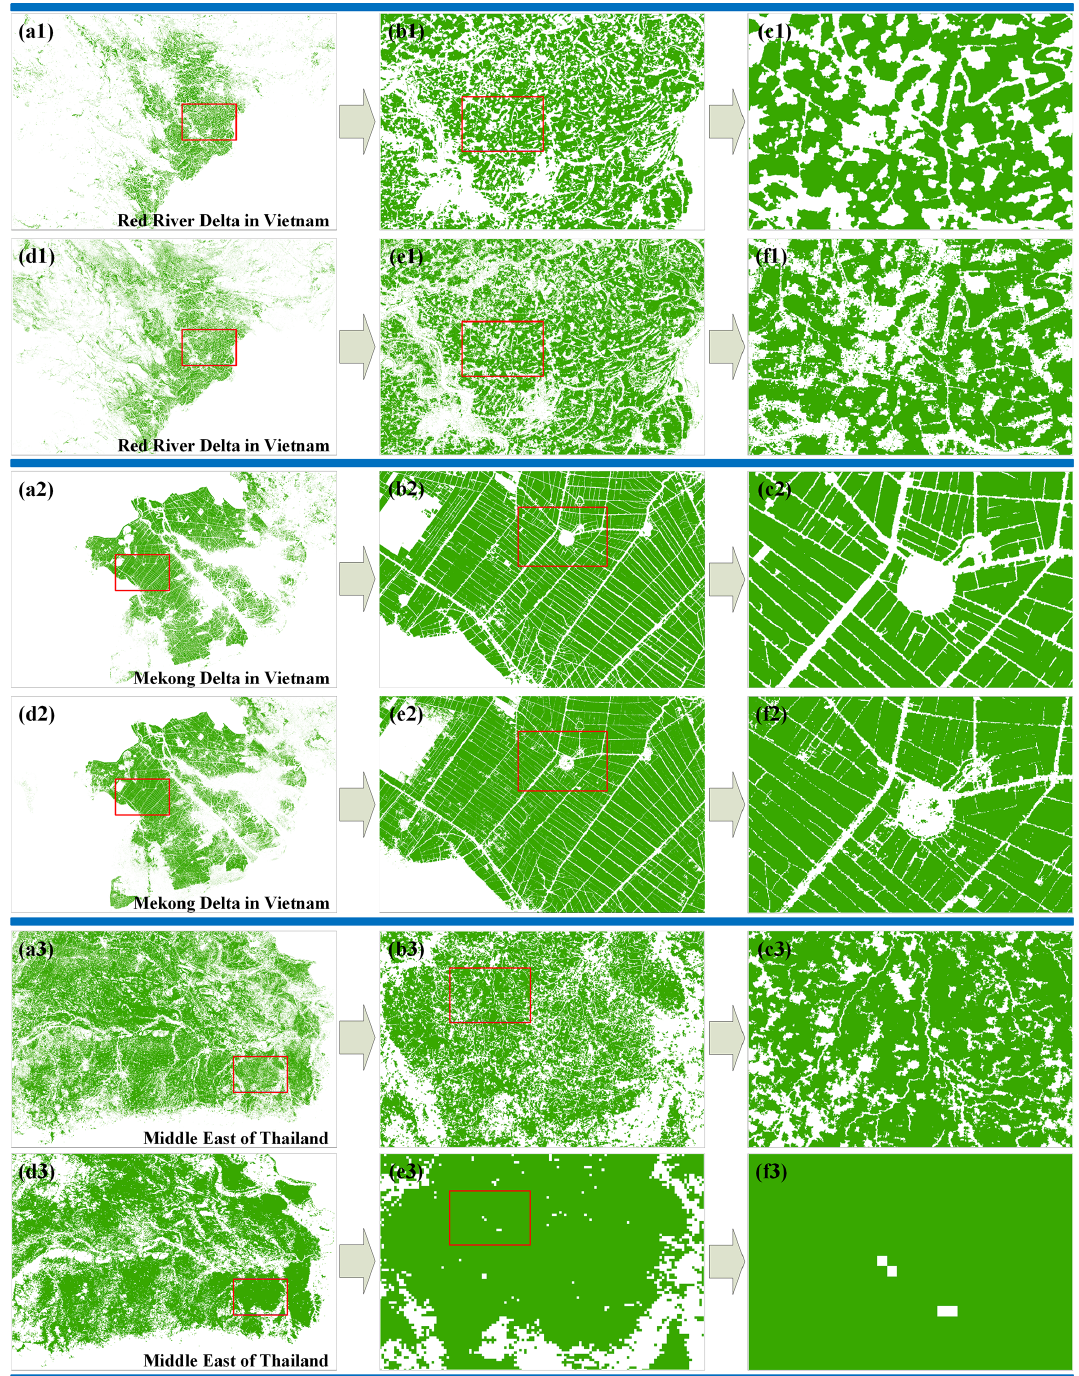
Figure 10. Comparison of our rice area map with available rice area products in typical regions. Our extraction results (a1–c1, a2–c2, a3– in the figures of the first column, and the figures in the third column show the enlarged views of the red boxes in the figures of the second column.